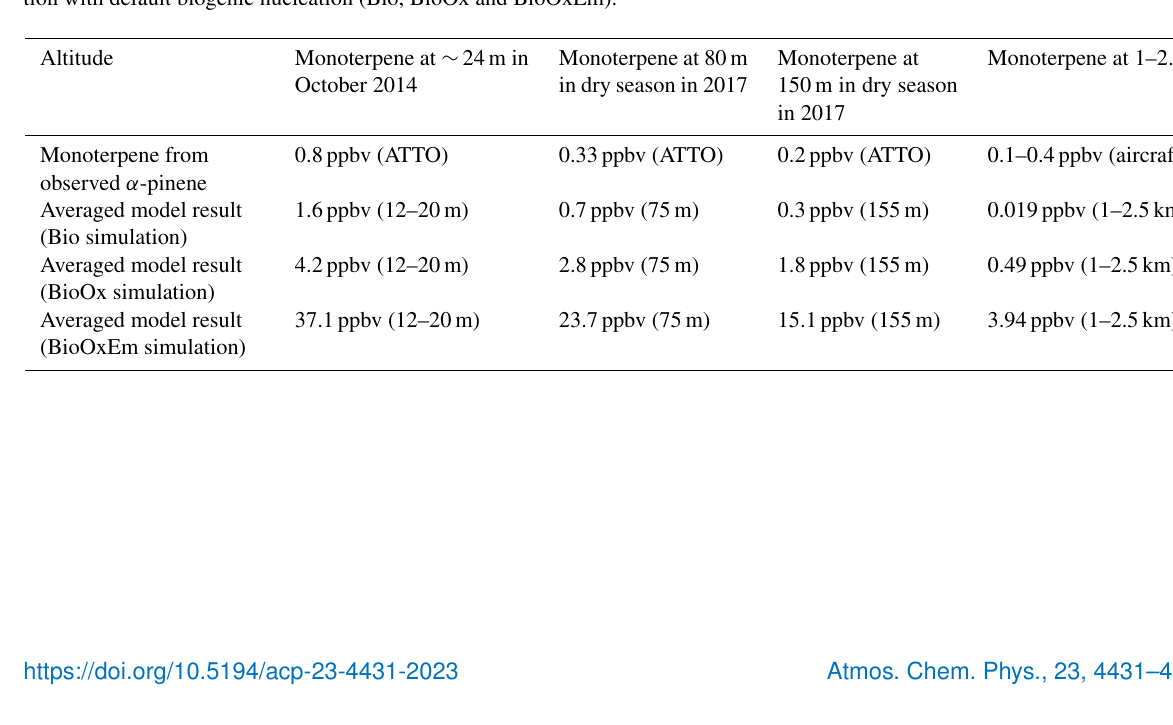
Table A1. Monoterpene concentrations from the observations and the domain and time-averaged monoterpene concentrations in the simula- tion with default biogenic nucleation (Bio, BioOx and